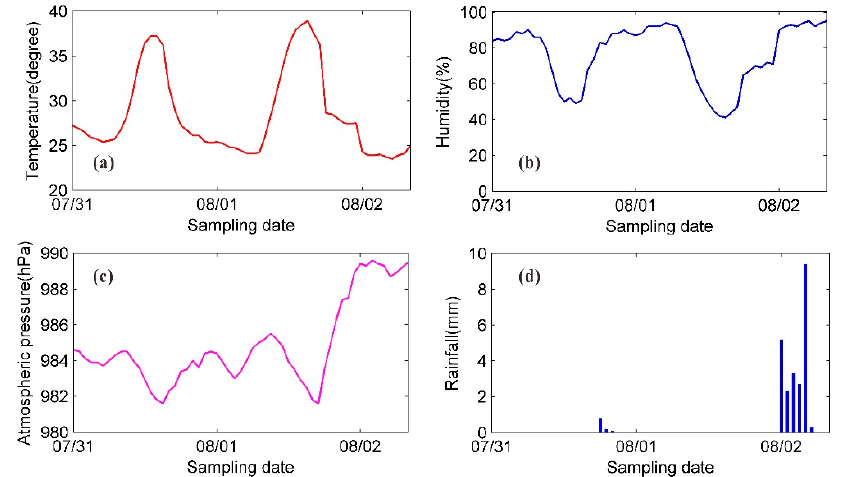
Figure 6. Variations in meteorological parameters during continuous deformation monitoring experiment: ( a ) temperature; ( b ) humidity; ( c ) atmospheric pressure; and ( d ) rainfall.